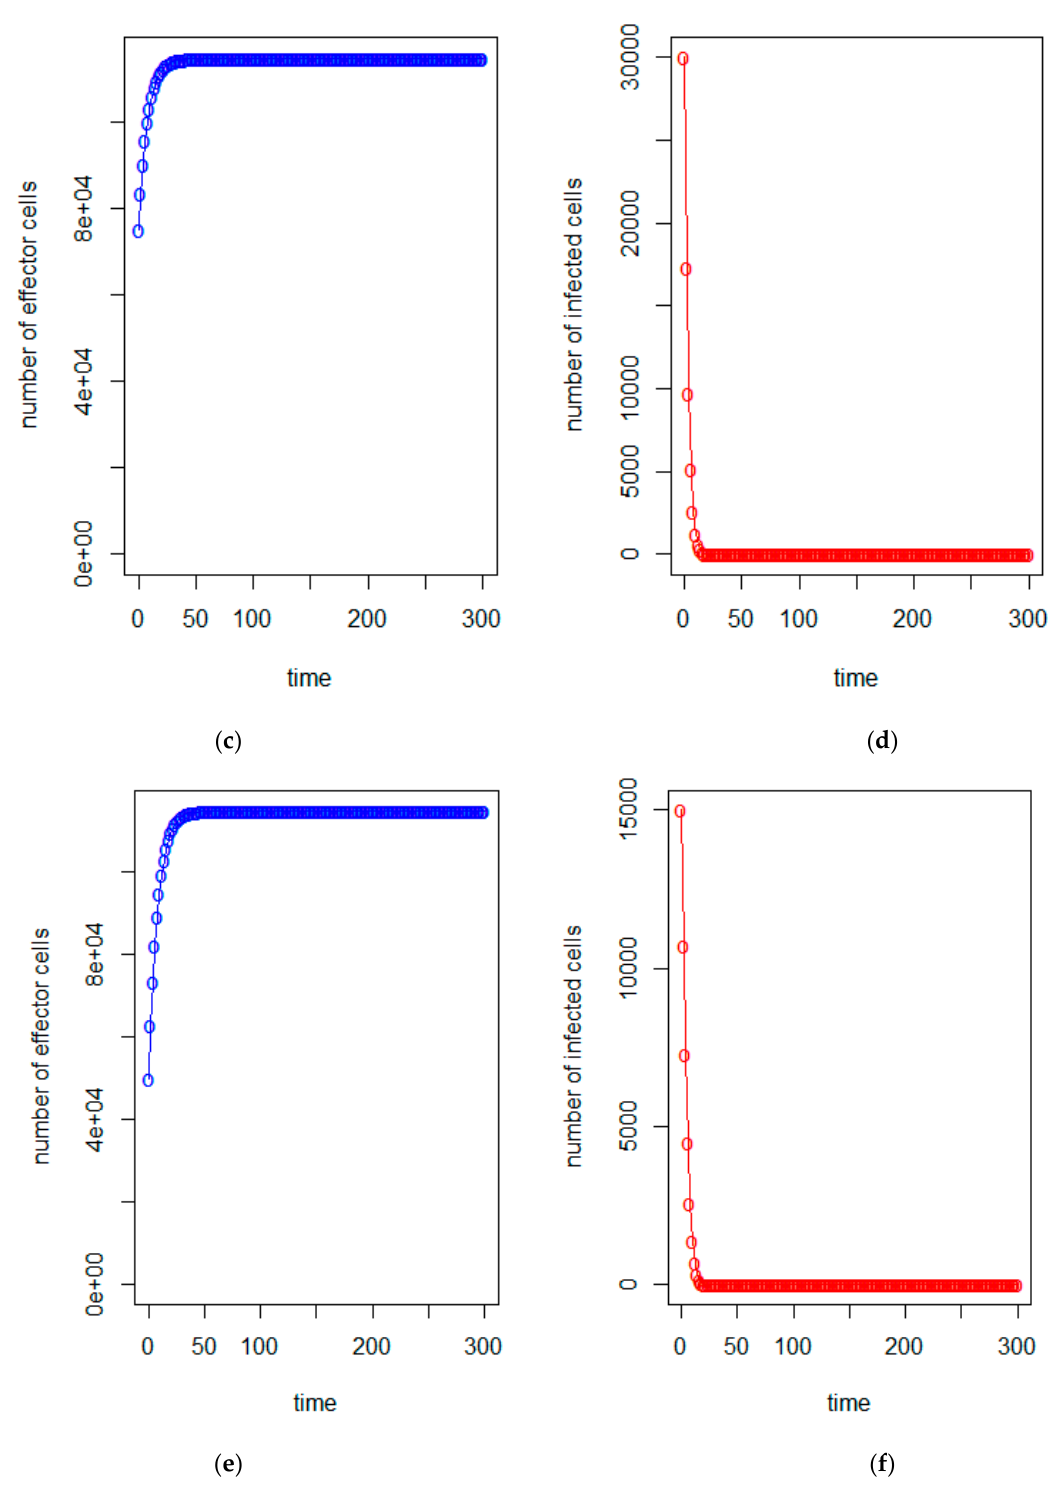
Figure 4. ( a , b ): The immune-effector cells ( a ) and virus-infected cells ( b ) vs. time (days); ( c , d ): The immune-effector cells ( c ) and virus-infected cells ( d ) vs. time (days). The same as Case 4, except I 0 = 75,000 cells; ( e , f ): The immune-effector cells ( e ) and virus-infected cells ( f ) vs. time (days).The same as Case 4, except V 0 = 15,000 cells. Case 5: Same as Case 1 (i.e., s = 7000), except b =4.3 × 10 − 4 .